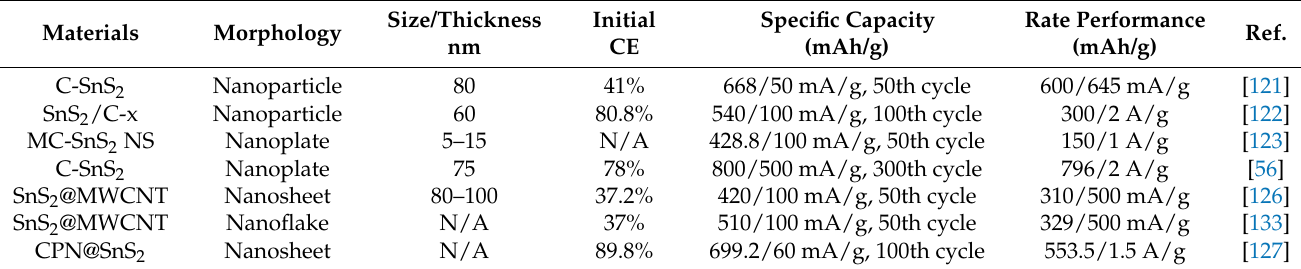
Table 2. Electrochemical performance of carbon-coated SnS 2 and SnS 2 -CNT-based